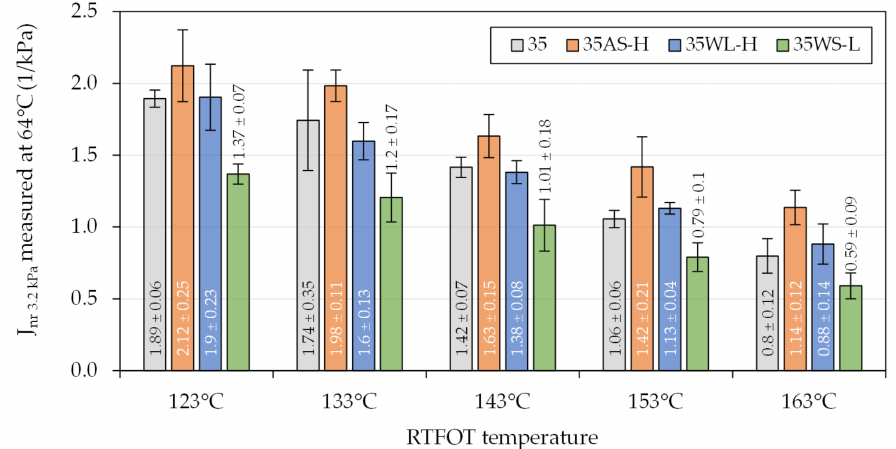
Figure 9. Non-recoverable creep compliance of the investigated asphalt binders based on the 35/50-penetration bitumen evaluated in the MSCR test.